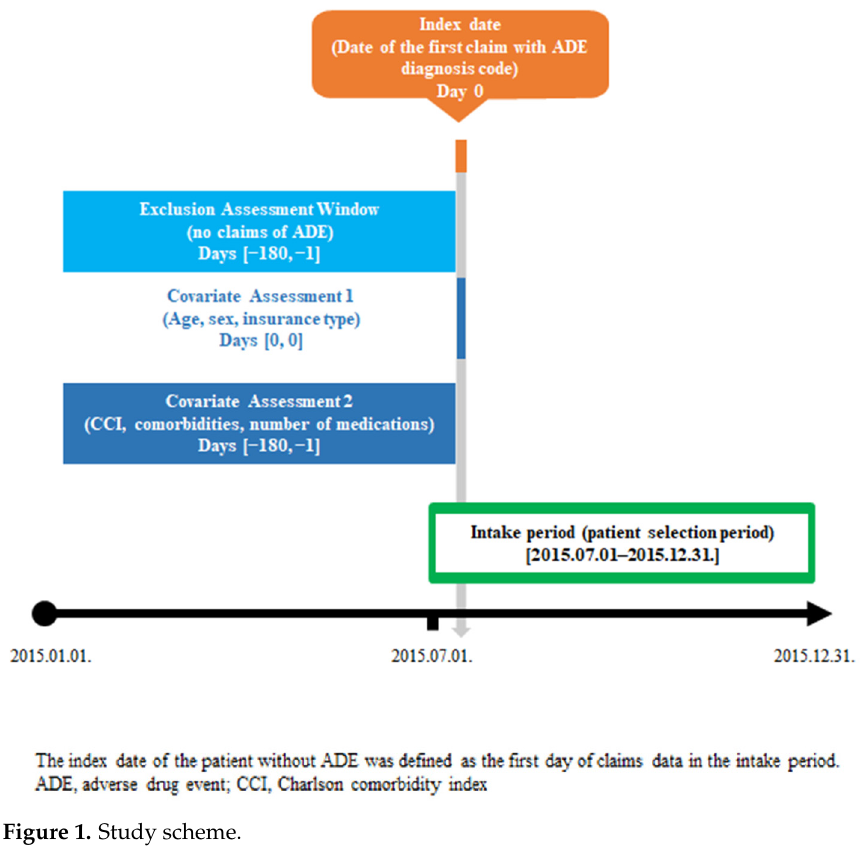
Figure 1. Study Figure 1. Study scheme.